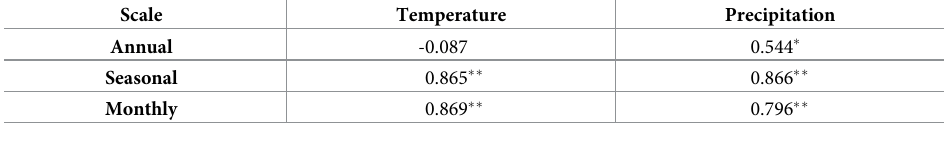
Table 3. The Pearson correlation coefficients of the climatic factors and NDVI at different time scales. Scale